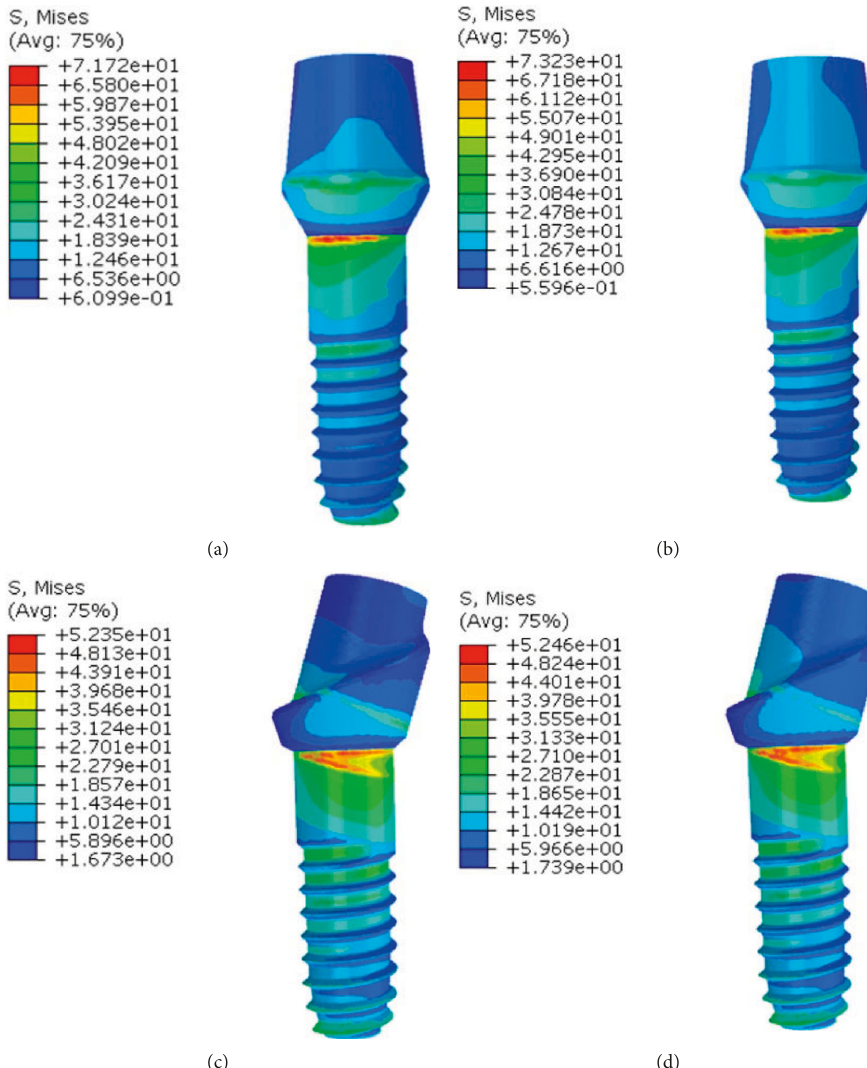
Figure 6: Stress distribution in abutments in model 2. (a), (c) PFBM; (b), (d)